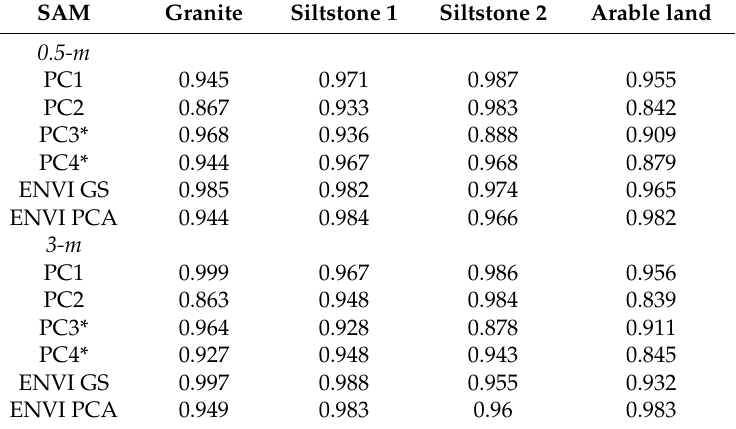
Table 12. SAM scores achieved when comparing the ASTER reference and the fused image spectrum. The higher the score the higher the match (0: no match, 1: identical spectrum). It was expected that the first two PCs have the potential to give good results when employing the PCA sharpening process, however PC3* and PC4* were used to compare the result and explain it in a wider